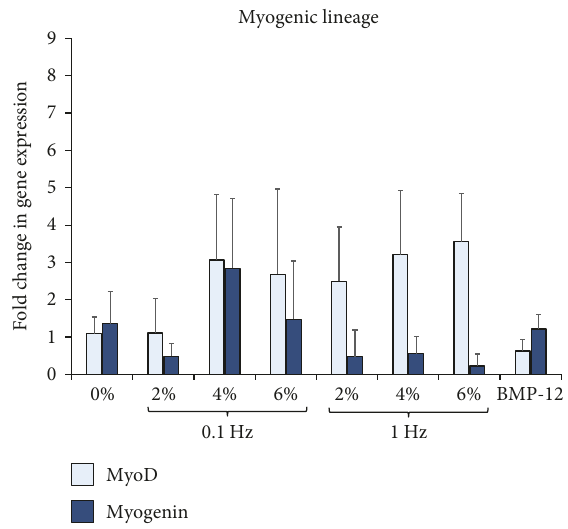
Figure 9: E ff ect of uniaxial tensile loading on myogenic gene expression of ASCs within 3D collagen sca ff olds. Gene expression pro fi les of ASCs encapsulated within collagen sca ff olds subjected to BMP-12 treatment or uniaxial loading at 0% (unloaded), 2%, 4%, and 6% strains at 0.1Hz and 1 Hz loading frequencies. The graphs depict fold changes in various myogenic markers: MyoD and myogenin. No signi fi cant increase of myogenic markers in ASCs was observed in any of the mechanically stimulated